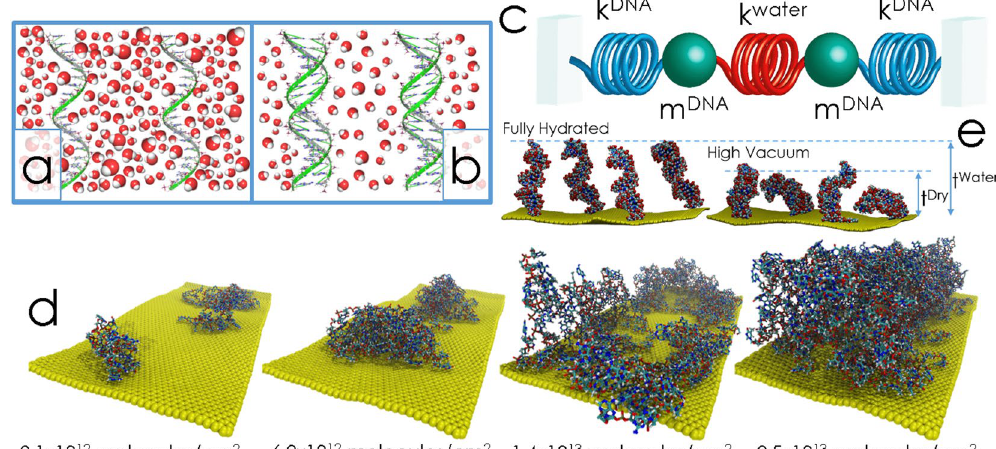
Figure 1. Schematics of the DNA-water interactions and mechanical analogy representation. Schematic cartoon of the hydrated ssDNA ( a ) and dsDNA ( b ). The number of water molecules depicted here is an estimation based on molecular dynamics simulations of hydrated layers. ( c ) Schematic cartoon of the mechanical analog of the DNA layer. Both the intermolecular interactions and the water molecules hold together the molecular components of the layer, giving as a result an effective spring constant. ( d ) Molecular dynamics simulations series for increasing molecular surface density from 3.1 × 10 12 molecules/cm 2 up to 2.5 × 10 13 molecules/cm 2 for fully hydrated randomly attached ssDNA molecules on a non-interacting surface of 136 nm 2 ; Na + ions were introduced to neutralize the excess of charge. ( e ) MD simulation showing the thickness difference between a fully hydrated DNA layer and the same layer at dry, high vacuum conditions. Note the structural effect of water molecules in the individual ssDNA molecules, see Supplementary Information for further